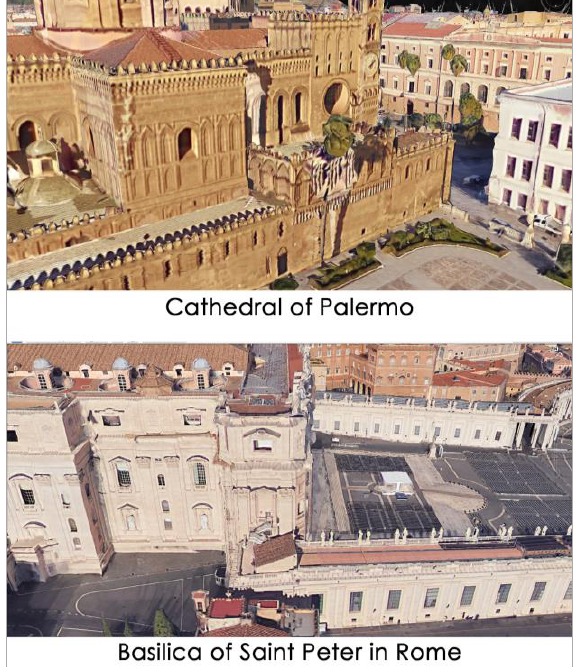
Figure 19. Model from Google Earth of the Cathedral